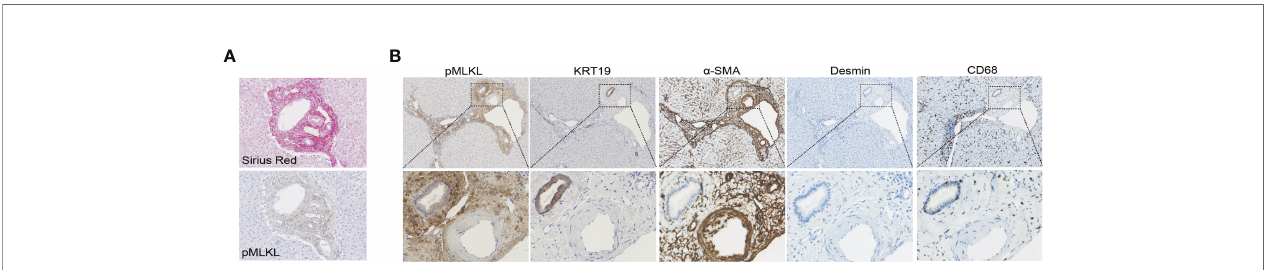
FIGURE 4 | Characterization of periportal cells expressed pMLKL. (A, B) Serial liver sections from T1 biopsies obtained from one donor liver were stained with Sirius Red, pMLKL, KRT19, a -SMA, Desmin, and CD68 (magni fi cation 100X). Enlarged images from the boxed area are shown in the bottom panel (magni fi cation 400X). ECM deposition was observed mostly in the periportal area and appeared to overlap with pMLKL positivity. Areas positive for pMLKL overlapped a lot with a -SMA + , but not Desmin + . Part of KRT19 + cells also displayed positive staining for pMLKL, while few CD68 + were observed to co-express pMLKL.